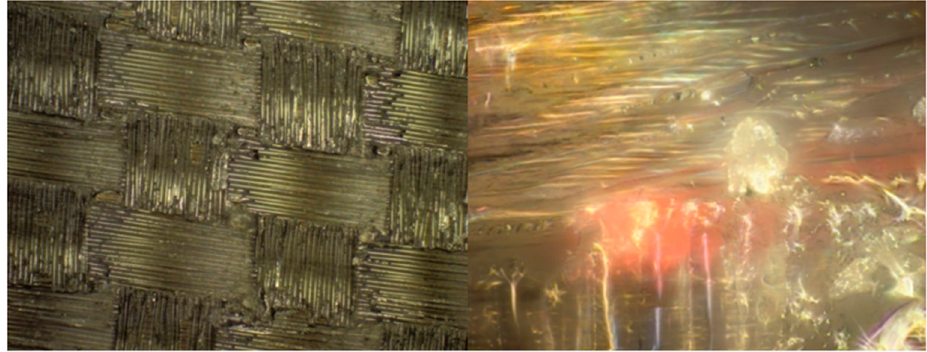
Figure 6. Microstructure of a composite laminate with the reinforcement of the IMS65 modular fabric [32].